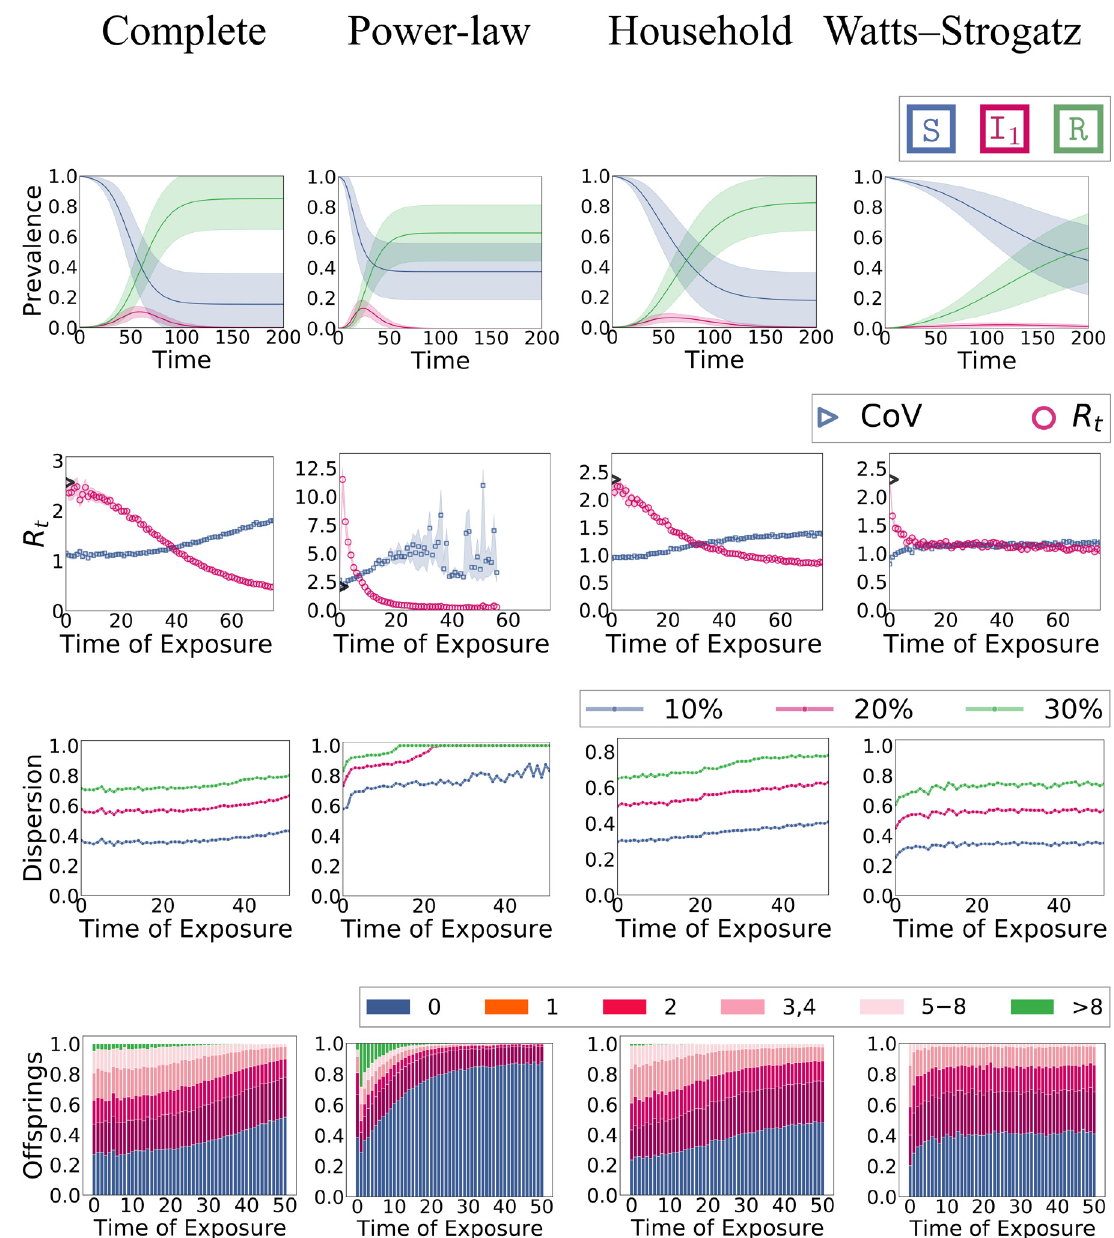
Fig 7. Experiment 1: Epidemic dynamics of different network types. Row 1 : Evolution in terms of mean fractions (and standard deviation) in each compartment over time. Row 2 : Effective reproduction number R (the empirical R 0 is shown as a black triangle) and t coefficient of variation of the offspring distribution (with 95% CI, note a significant amount of noise in the power-law case). Row 3 : Top- k plots: The fraction of new infections that can be attributed to a particular fraction of infected nodes. Row 4 : Characterization of the offspring distribution in terms of the fraction of nodes that cause a specific number of secondary